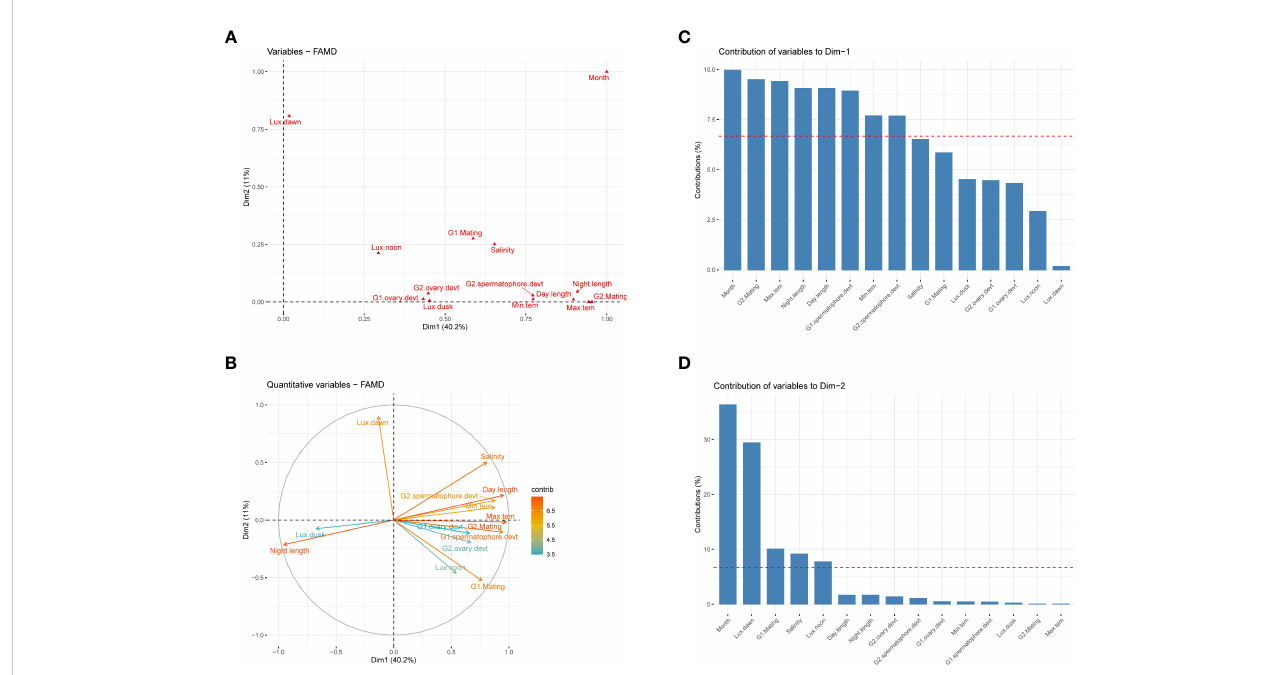
FIGURE 6 Principal component analysis of environmental and reproductive parameters of captive-reared Penaeus indicus. (A) : The PCA of quantitative and qualitative variables by Factor Analysis of Mixed Data (FAMD), (B) : Correlation circle of quantitative variables, (C) : Relative contribution of variables in fi rst dimension, (D) : Relative contribution of variables in second